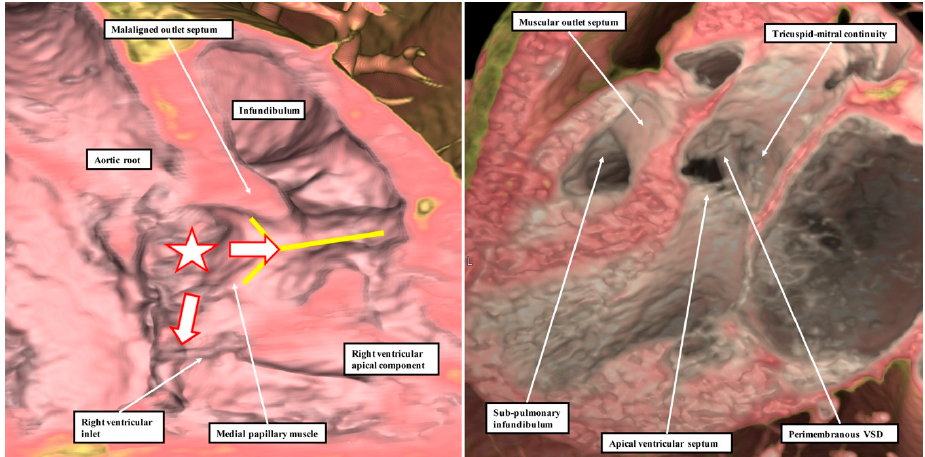
Figure 9. These images are taken from a computerised tomographic dataset made from a patient with a ventricular septal defect (VSD) opening centrally at the base of the right ventricle, as shown by the white star with red borders in the left -hand panel. As is then shown by the white arrows with red borders, however, the defect is sufficiently large to extend so as to open in part to the inlet of the right ventricle, but also to the right ventricular outlet. It opens to the outlet component through the limbs of the septal band, shown by the yellow “Y”. It is difficult, therefore, when assessing its geographical categorisation, to determine whether the defect should be deemed to be inlet, central, or outlet. It is better described as being confluent. The view from the left ventricle, as seen in the right -hand panel, shows that there is no question but that the defect is perimembranous, since it is bordered postero-inferiorly by fibrous continuity between the leaflets of the tricuspid and mitral valves. Note also that, as seen in the left -hand panel, the muscularised proximal cushions can still be recognised as producing a malaligned myocardial outlet septum in this setting of deficient ventricular septation.